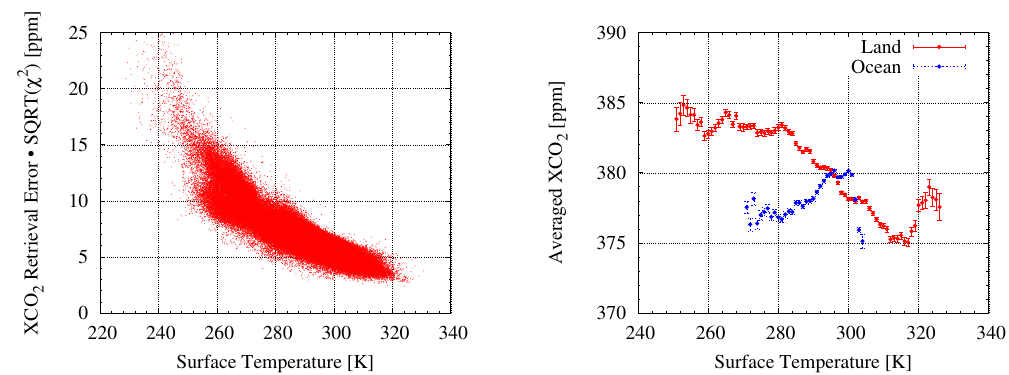
Figure 2: On the left: Total error (obtained multiplying the retrieval error by the SQRT of the χ 2 ) of XCO 2 retrieved from IASI spectra with the KLIMA code plotted as a function of the surface temperature. On the right: Averaged XCO 2 as a function of the surface temperature binned over 1